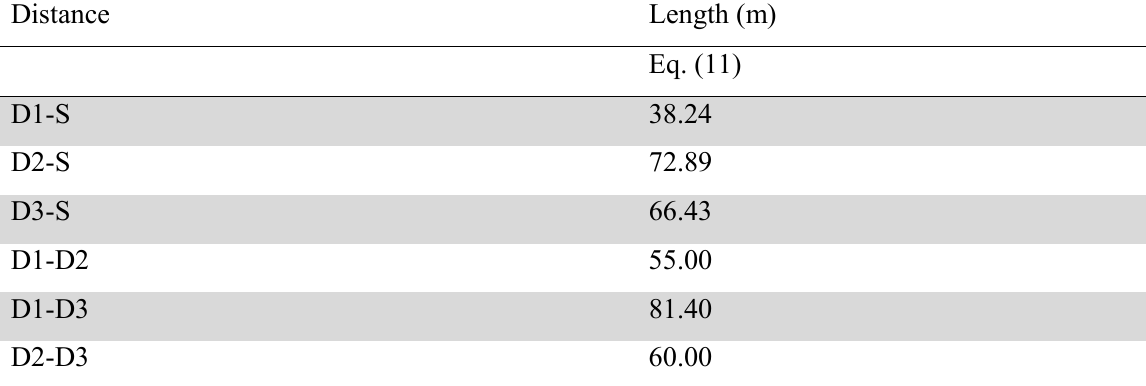
Distance between supply and demand locations Distance